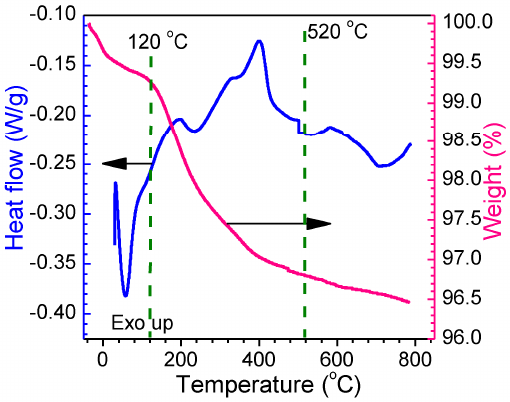
Figure 1. TGA-DSC thermography of 0.5 at % Eu-SnO 2 nanoarrays.